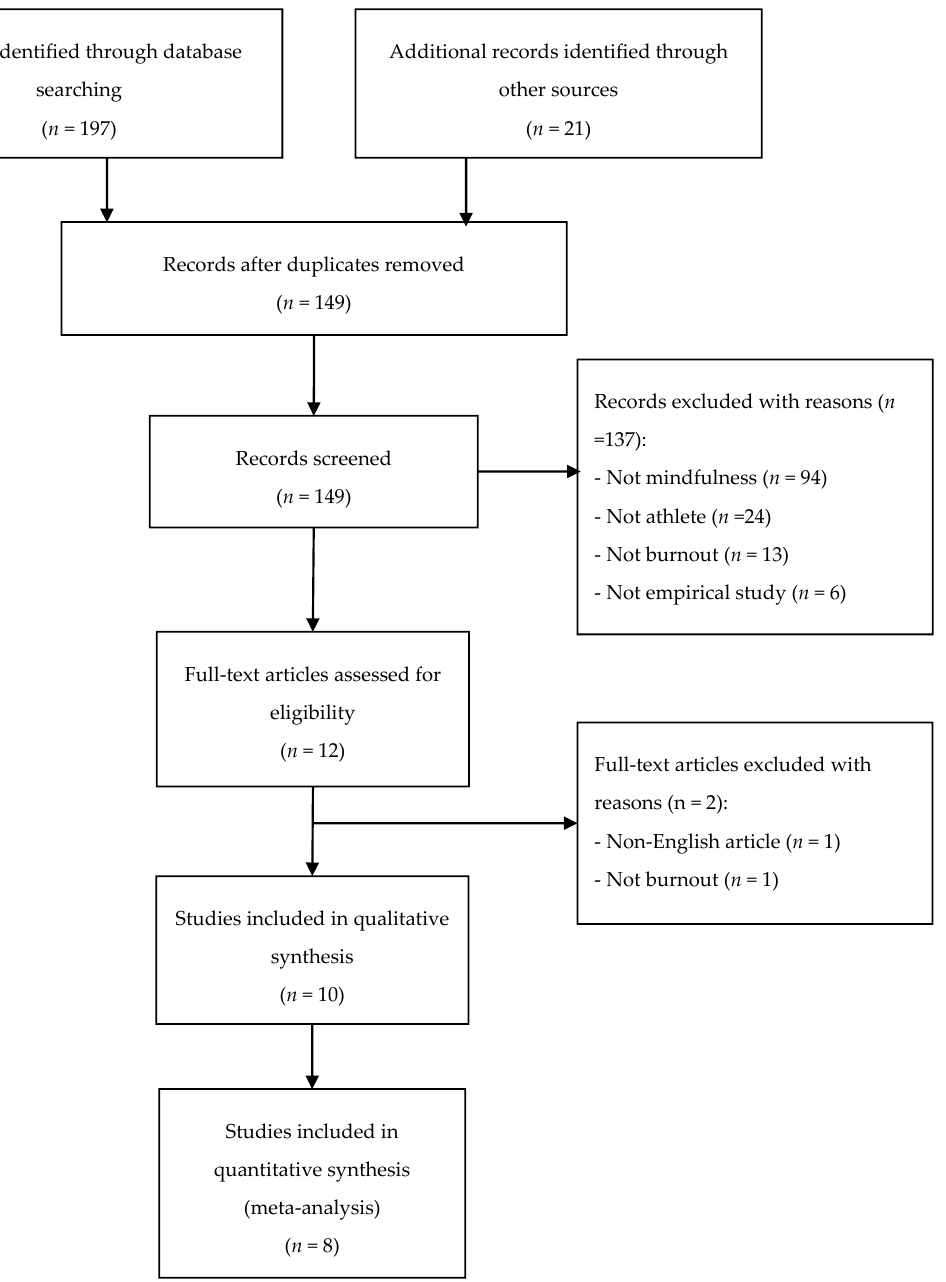
Figure 1. Study selection process. 223